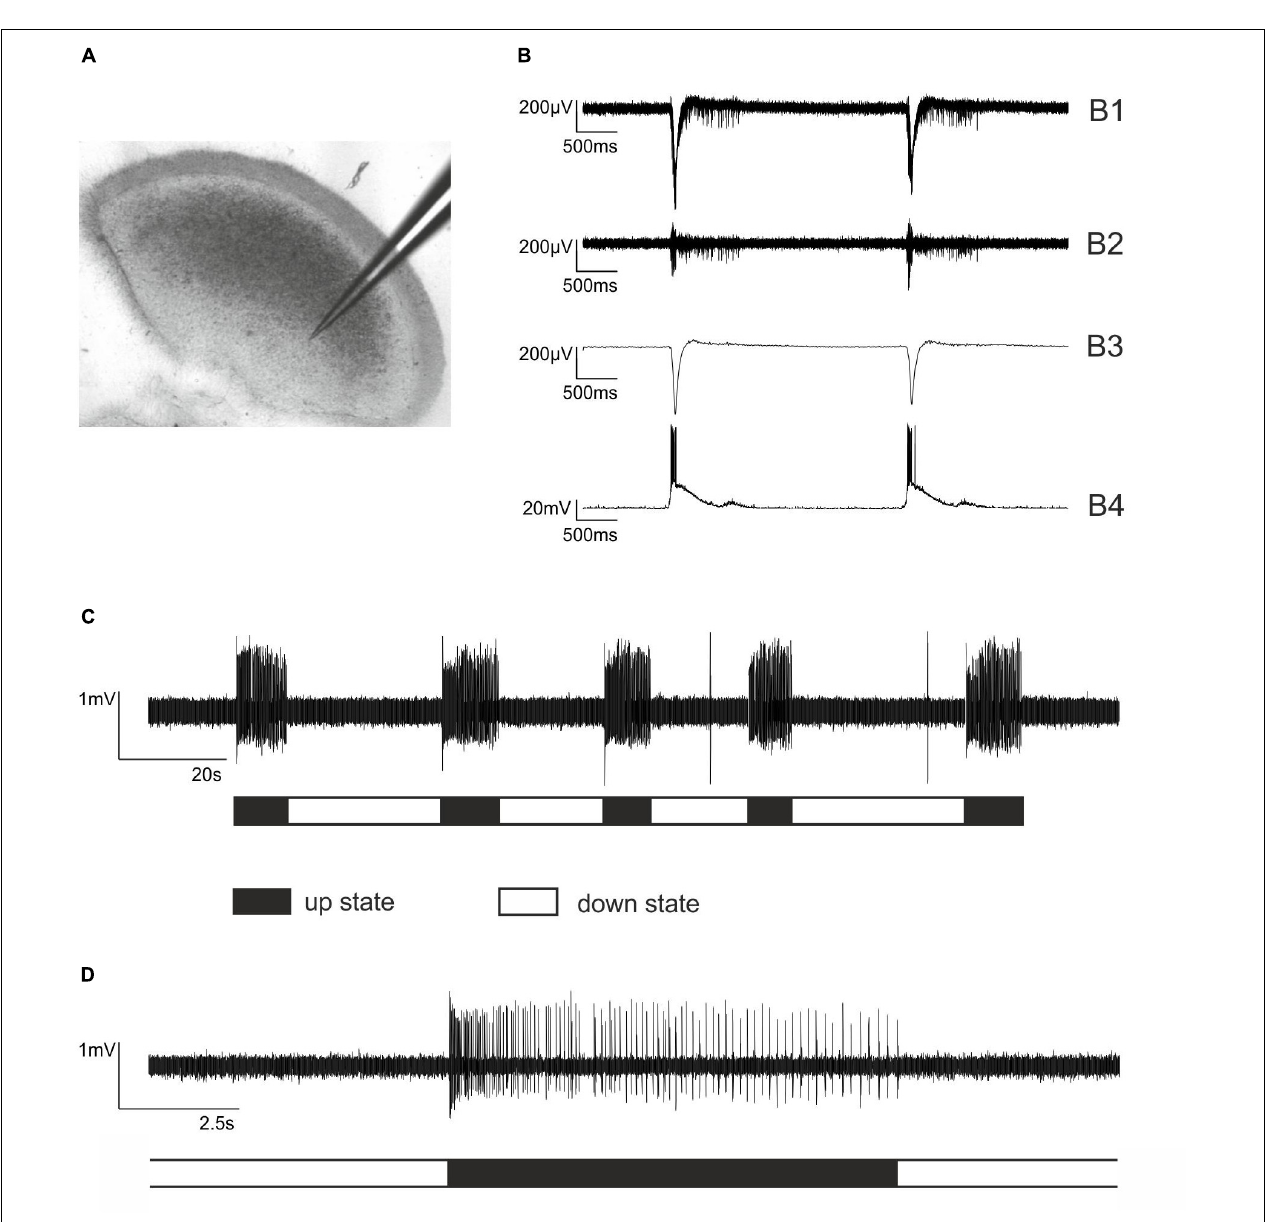
FIGURE 1 | Extracellular recordings from cortical slice cultures and firing patterns of cultured cortical neurons. (A) An electrode made of borosilicate glass placed in an organotypic cortical slice culture. Note that the cortical architecture is largely preserved. (B) Simultaneous extra- and intracellular recording from a neocortical cultured slice to illustrate the functional properties of the network. (B1) Raw trace of extracellular recording. (B2) The signal was band pass filtered 250 – 5000 Hz to allow for action potential detection. (B3) Local field potential, sometimes referred to as “micro-EEG,” which is obtained from B1 by low pass filtering 1 – 40 Hz. (B4) Simultaneous intracellular current clamp recording from a cortical pyramidal neuron within the network. The liquid junction potential of –17 mV was subtracted. (C) The typical firing pattern of cultured cortical neurons is characterized by alternating phases of high neuronal activity, so-called bursts or up states and phases of very low activity, called silent period or down state. Here, five bursts of action potential firing (up states) are displayed, halted by silent periods (down states). (D) One single up state at a higher temporal resolution. Each vertical line represents a single action potential. Note that the phase of neuronal activity at the beginning of the up state is rather high, followed by moderate activity that is slowly